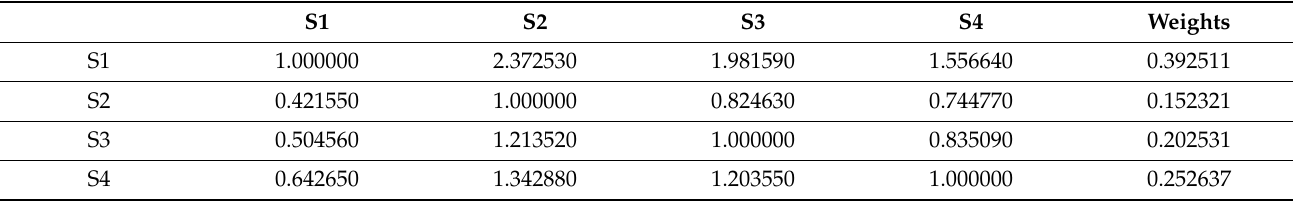
Table 6. The defuzzified pairwise comparison matrix.